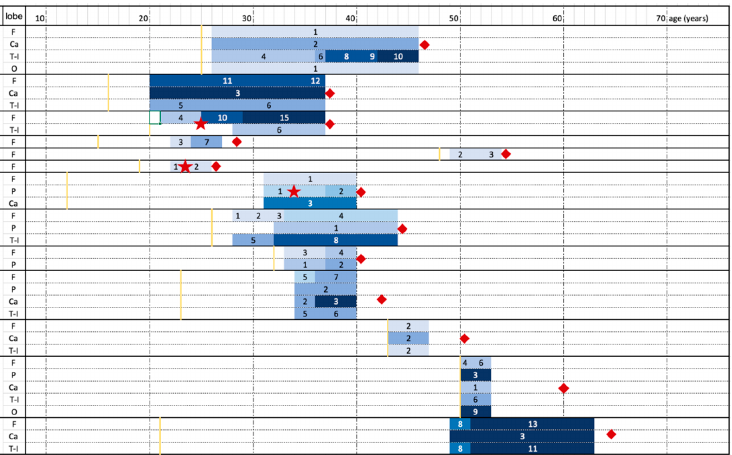
Figure 1. Atrophy progression timeline for each patient. Patients’ age (years) increases from left to right. The shades of blue represent MRI controls and worsening of the degree of atrophy (according to numerical values deriving from the sum of the scores of different areas, as mentioned in Table 2). Yellow line represents clinical onset; red squares represent patients’ last clinical evaluation and red occipital lobe. stars the surgical intervention. Patient 10 and 13 died after last follow-up due to non-neurological disease. F = frontal lobe; Ca = Caudate nucleus; T-I = temporoinsular lobes; P = parietal lobe; O = occipital